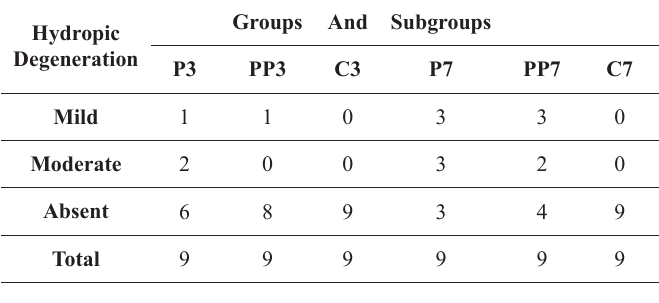
TABLE 3 - Frequency of hydropic degeneration in the animals of the 3 groups (P, PP and C) at both time points (3 and 7 days) - subgroups P3, P7, PP3, PP7, C3, C7): P Group